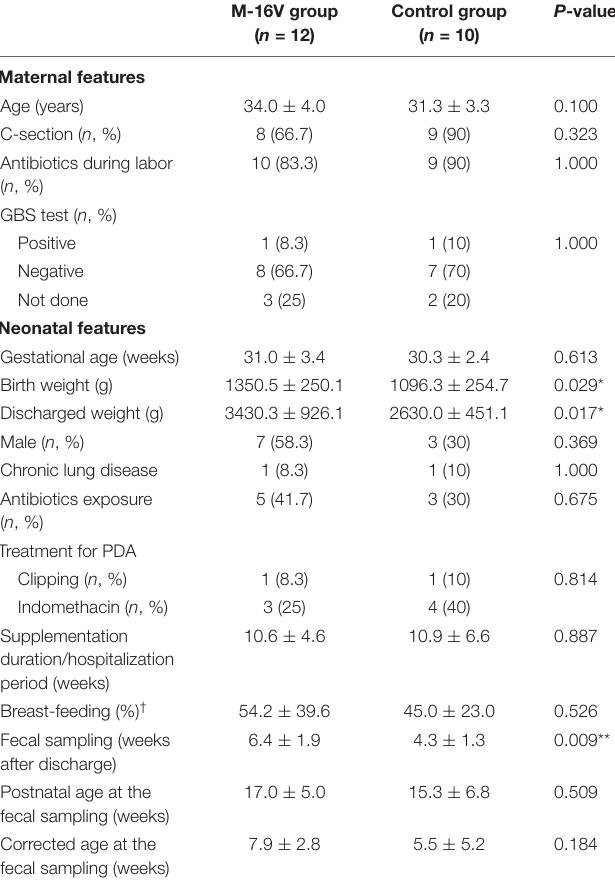
TABLE 1 | Characteristics of the